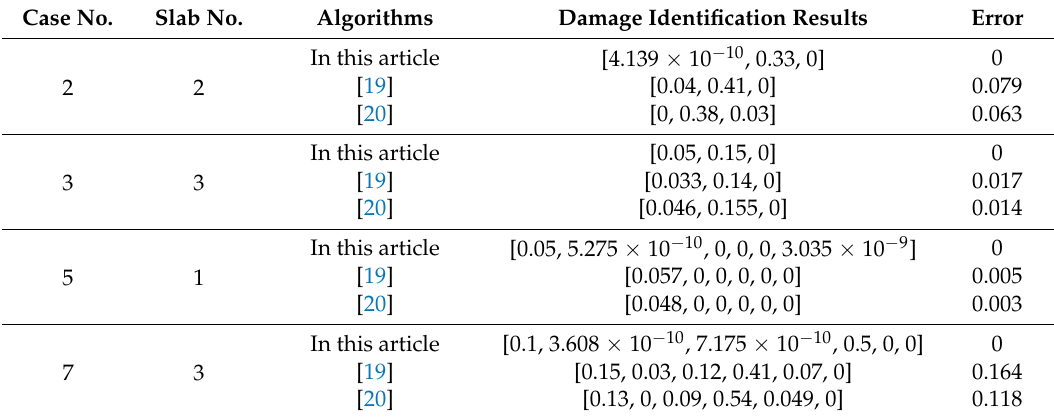
Table 11. Hinge joint damage identification results